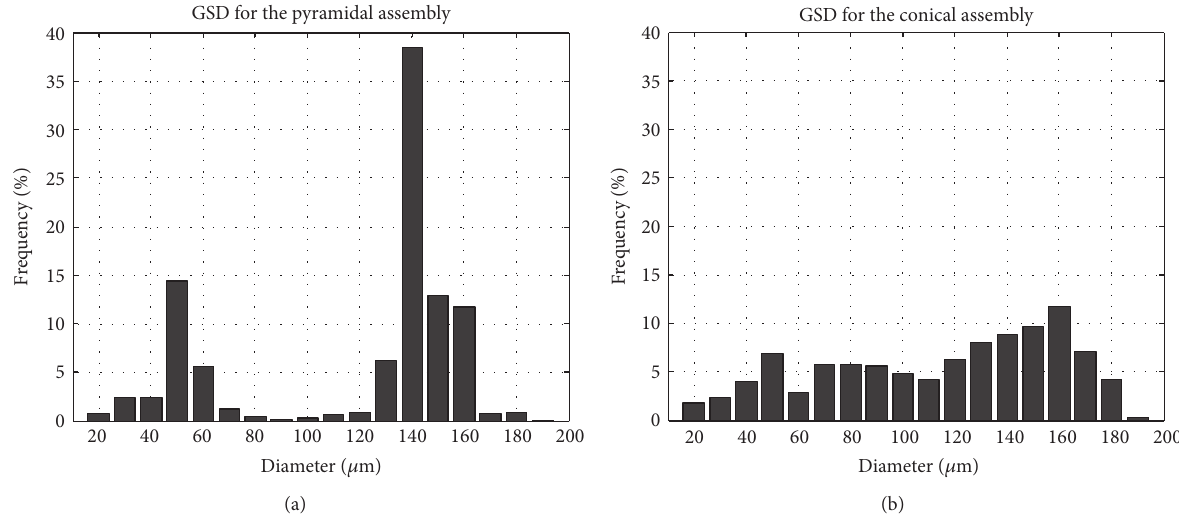
Figure 14: Gap Size Distribution (GSD) for the pyramidal assembly (a) and for the conical assembly